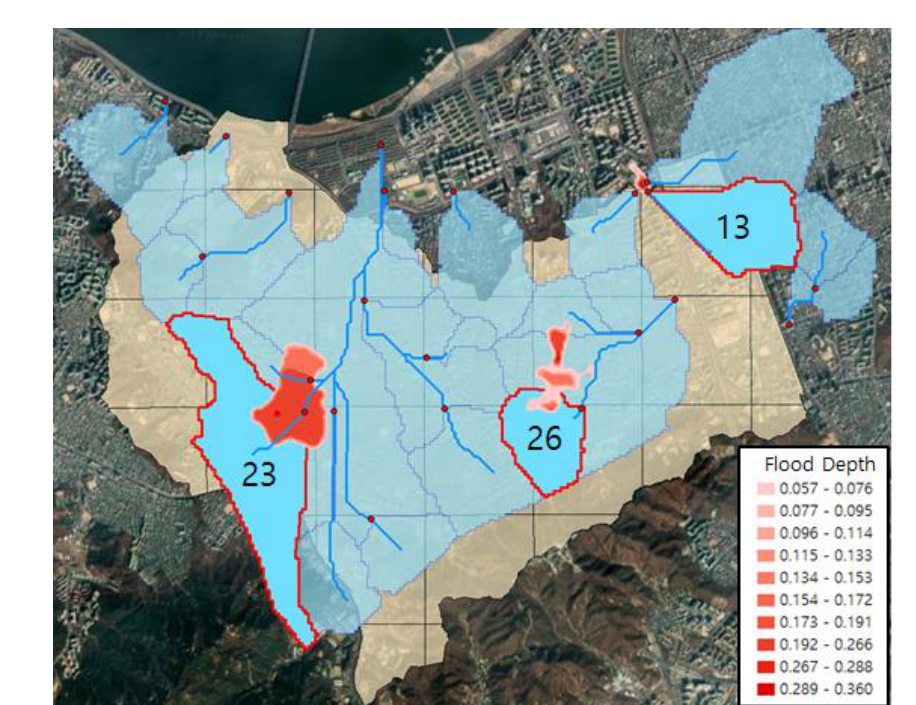
Figure 15. Flood depth result.